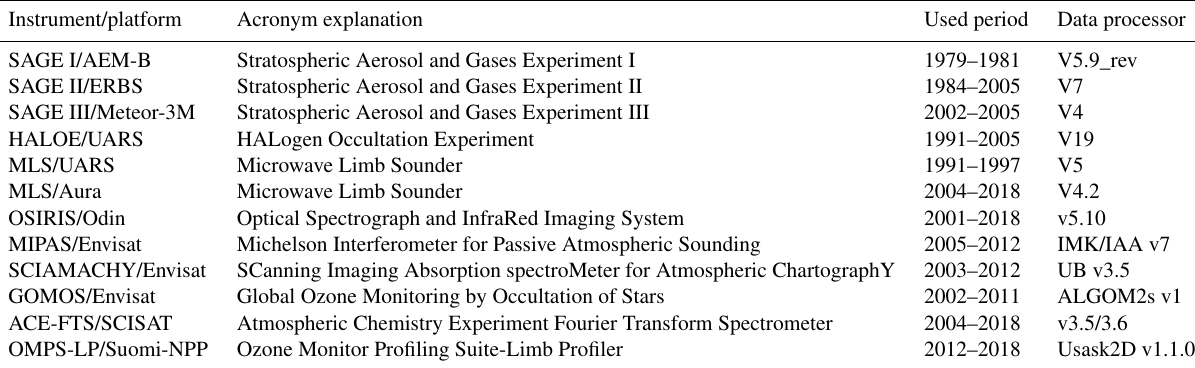
Table 2. Basic information about individual satellite data sets used in the merged data sets.